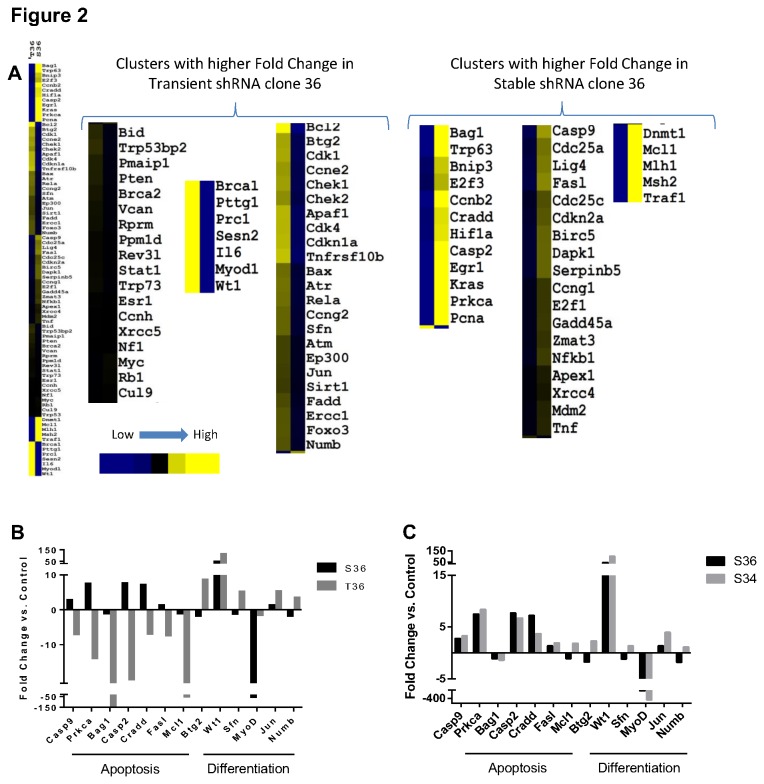
Gene expression o f p53 target genes after p53 loss.(A) Heat map generated by centroid linkage of the Euclidian distance of mean centered fold change values of transient transfection of shRNA plasmid 36 (T36) and stable line created with plasmid 36 (S36) using a control line (created with scrambled shRNA) as a common divisor, 2-((T36-Normalizers) – Control) compared to 2-((S36-Normalizers) – Control), (n = 1). The negative inverse used for fold changes between 0 and 1. Clusters were then divided into two categories, those with higher expression in T36 and those with higher expression in S36. (B) Fold change values plotted for genes involved in apoptosis or differentiation with a fold change between treated and control cells greater than two (C) Comparison of stable clones of varying p53 expression. Plot of the same gens as in (B) but between S36 and a stable line created with clone 34 (S34) show stable p53 knockdown irrespective of the level of knockdown, have a much more similar expression pattern than seen between transient and stable.